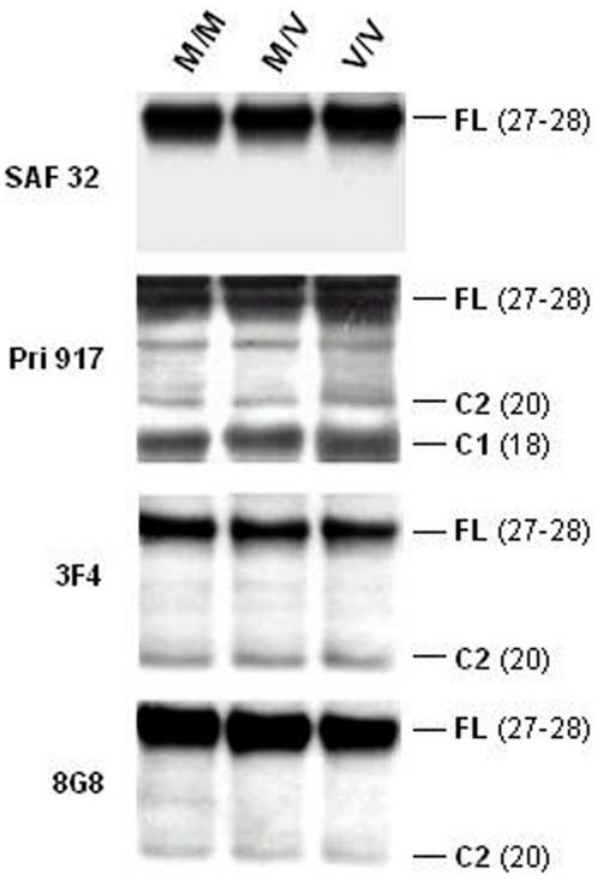
Figure 2. PrPC cleavage analysis. Immunoblots of truncated proteins from the three PRNP codon 129 genotypes in PBMCs. After PNGase treatment, denatured lysates from 10 6 PBMCs were tested by Western Blot analysis using 4 antibodies to span the large PrP region: SAF32 (79–91), 8G8 (95–110), 3F4 (109–112) and PRI 917 (216–221). The 27–28 kDa band corresponds to the M.W. of the unglycosylated Full- Length (F.L.) protein, while the bands near 20 kDa and 18 kDa correspond to the C2 and C1 fragments, respectively.